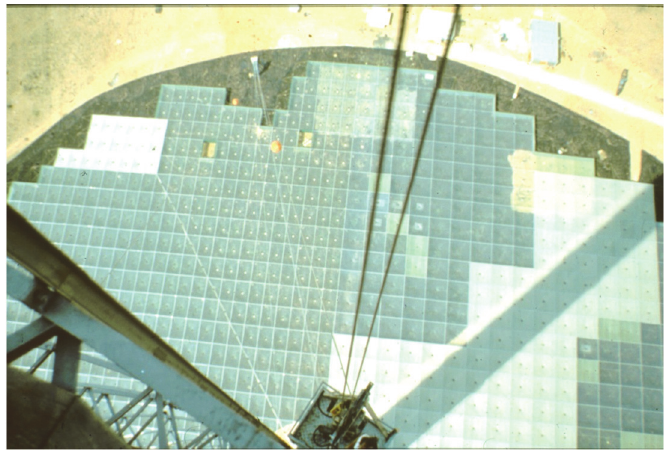
Figure 4. Top view of canopy of 50 kW SUTPP prototype at Manzanares, Germany, reproduced with permission from [68], Elsvier, 2022.